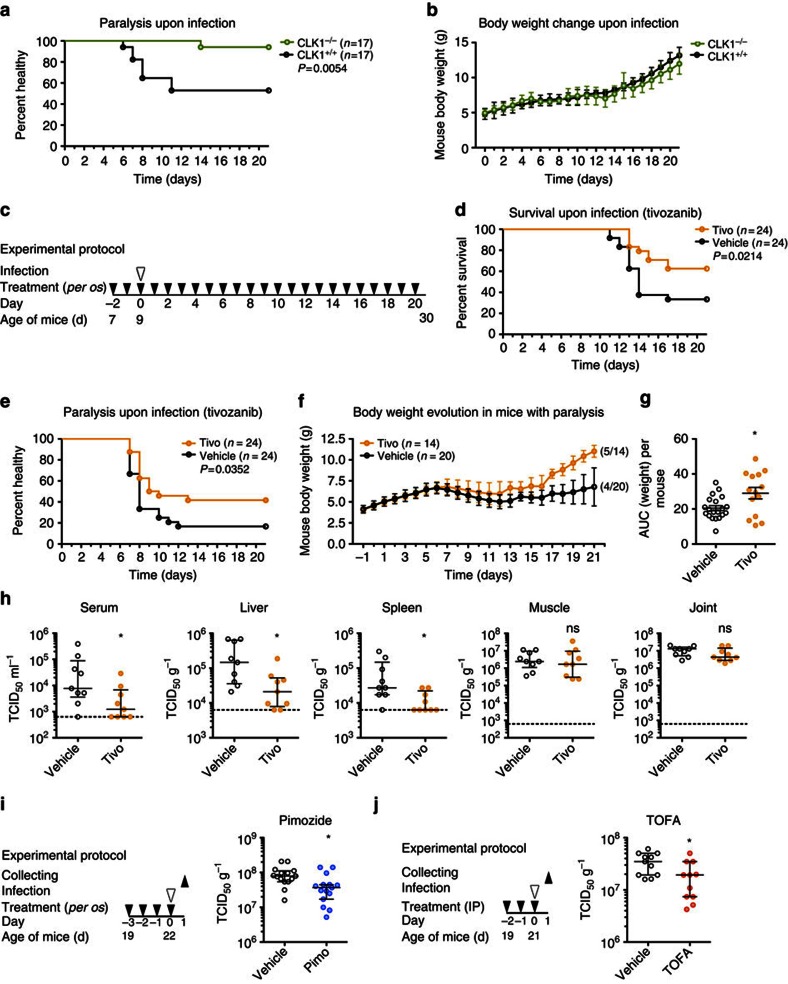
In vivo validation of selected chemical inhibitors and proviral factors.(a,b) Health status and body weight evolution in 9-day-old C57BL/6clk1−/− or C57BL/6clk1+/+ mice infected intradermally with CHIKV C21 (104 PFU) and killed at the appearance of paralysis. (c) Experimental design of the intradermal infection of the young mouse model used for tivozanib. (d–f) Effect of daily tivozanib (tivo) treatment on C57BL/6 mouse survival, paralysis and body weight change in response to CHIKV C21 infection. (g) Health status of each mouse with paralysis, estimated by measuring the area under the body weight curve. (h) CHIKV viral load measured 3 days post infection in the indicated organs obtained from mice treated with tivozanib as in c (n=9 for all data sets). (i,j) Experimental design of the footpad infection of adult mice model used and viral titres measured in C57BL/6 mice treated with pimozide (pimo, per os, n=15 for both data sets) or TOFA (i.p., n=11 for both data sets) or the corresponding vehicles before infection with CHIKV C21 (103 PFU). Data in b,f and g represented as the mean±s.e.m.; in h,i and j as the median±interquartile range; each dot represents one mouse. All data obtained from at least two independent experiments. Statistics were calculated using Log-rank (Mantel–Cox) test in a,d and e, two-sided t-test for two independent samples in g and Mann–Whitney test in h,i and j, (*P<0.05; NSP≥0.05). AUC, area under curve; d, days; i.p., intraperitoneal; NS, not significant.